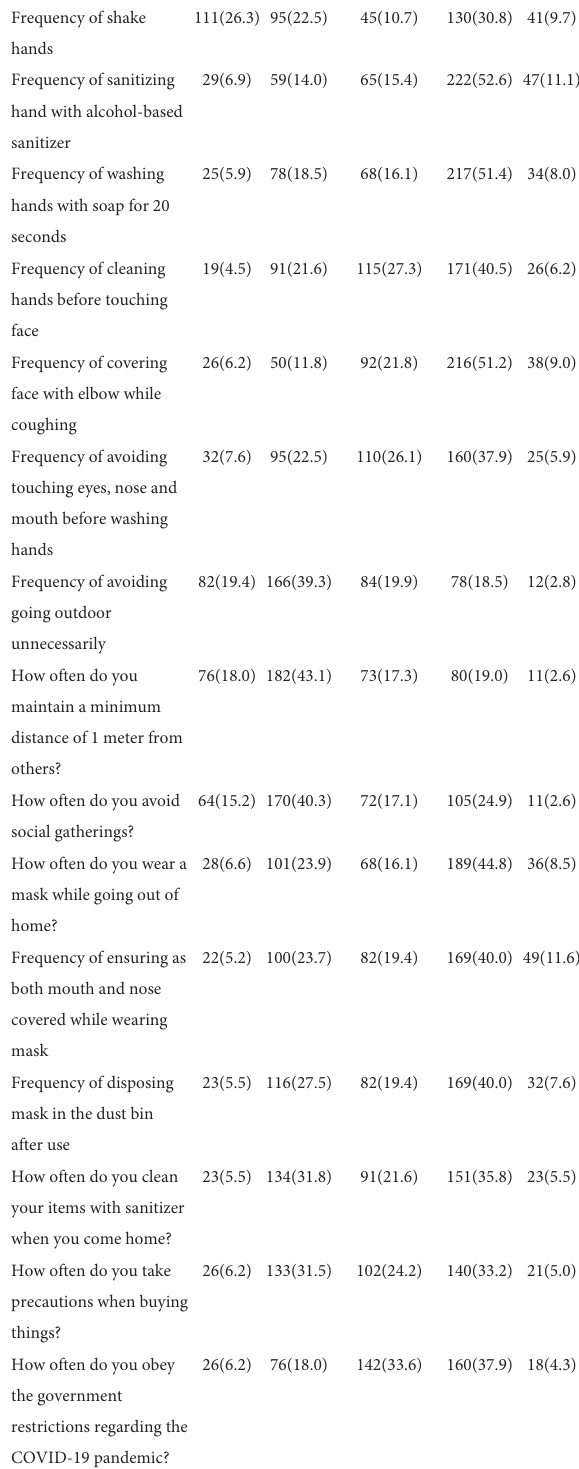
TABLE 3 COVID-19 personal experience and Vaccine uptake of participants at Jimma town 2021, Jimma, Ethiopia. Variable Category